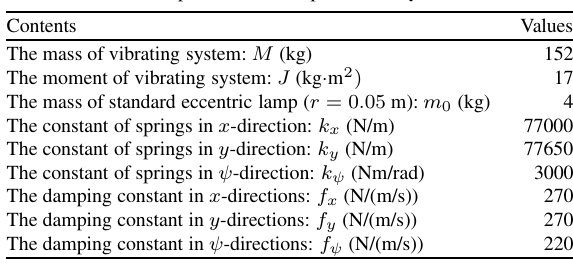
Fig. 6. The angle of the general dynamic symmetry.